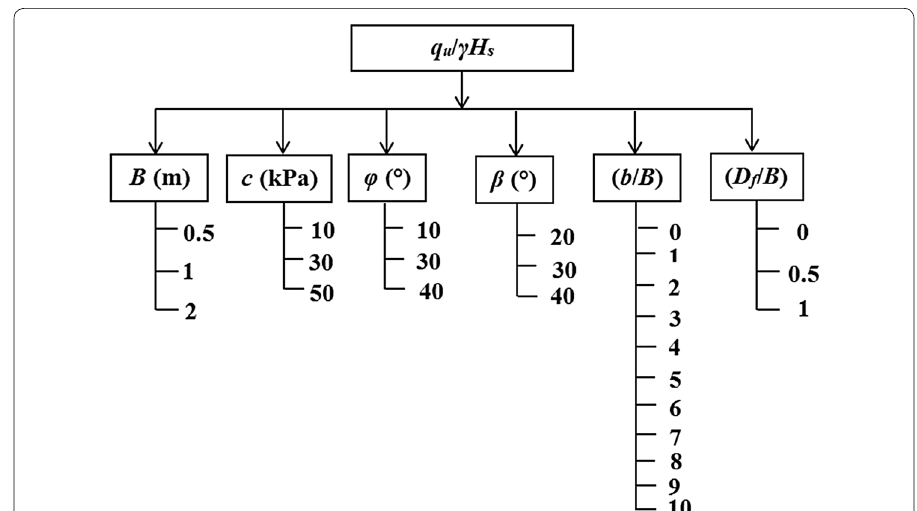
Fig. 4 Chart of varying geotechnical and geometrical parameters